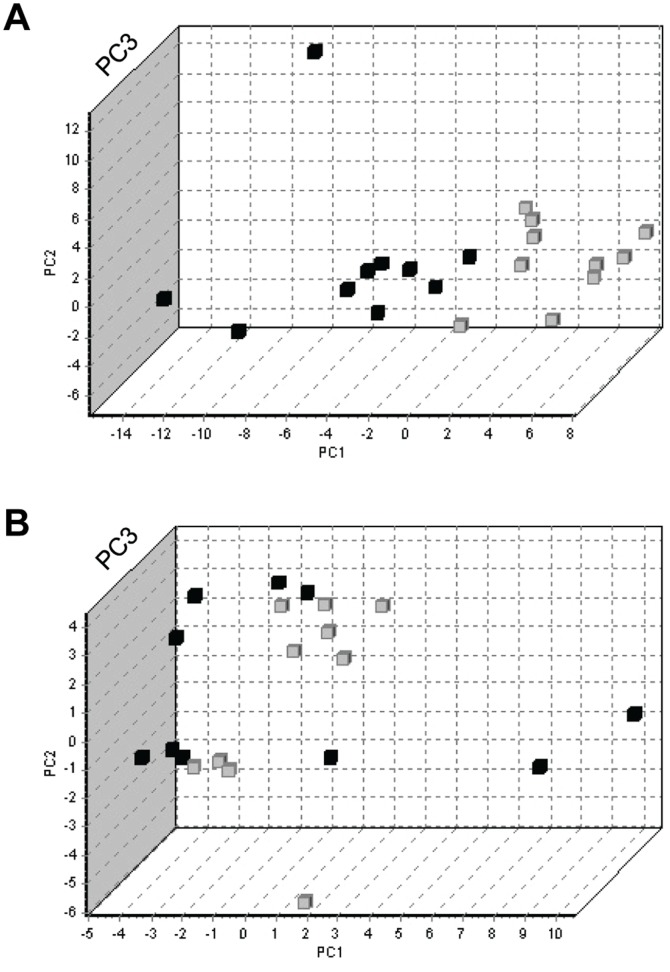
Principal component analysis (PCA) of the panel screening results.(A) PCA analysis of the top-50 ranking (lowest P-values in t-test) miRNAs of the panel screening; (B) PCA analysis of the bottom-50 ranking miRNAs (highest P-values in t-test). Black symbols represent young patients; grey symbols represent older, frail patients. PC1, PC2 and PC3 on X, Y and Z-axis represent the 3 principal components generated by this statistical algorithm.